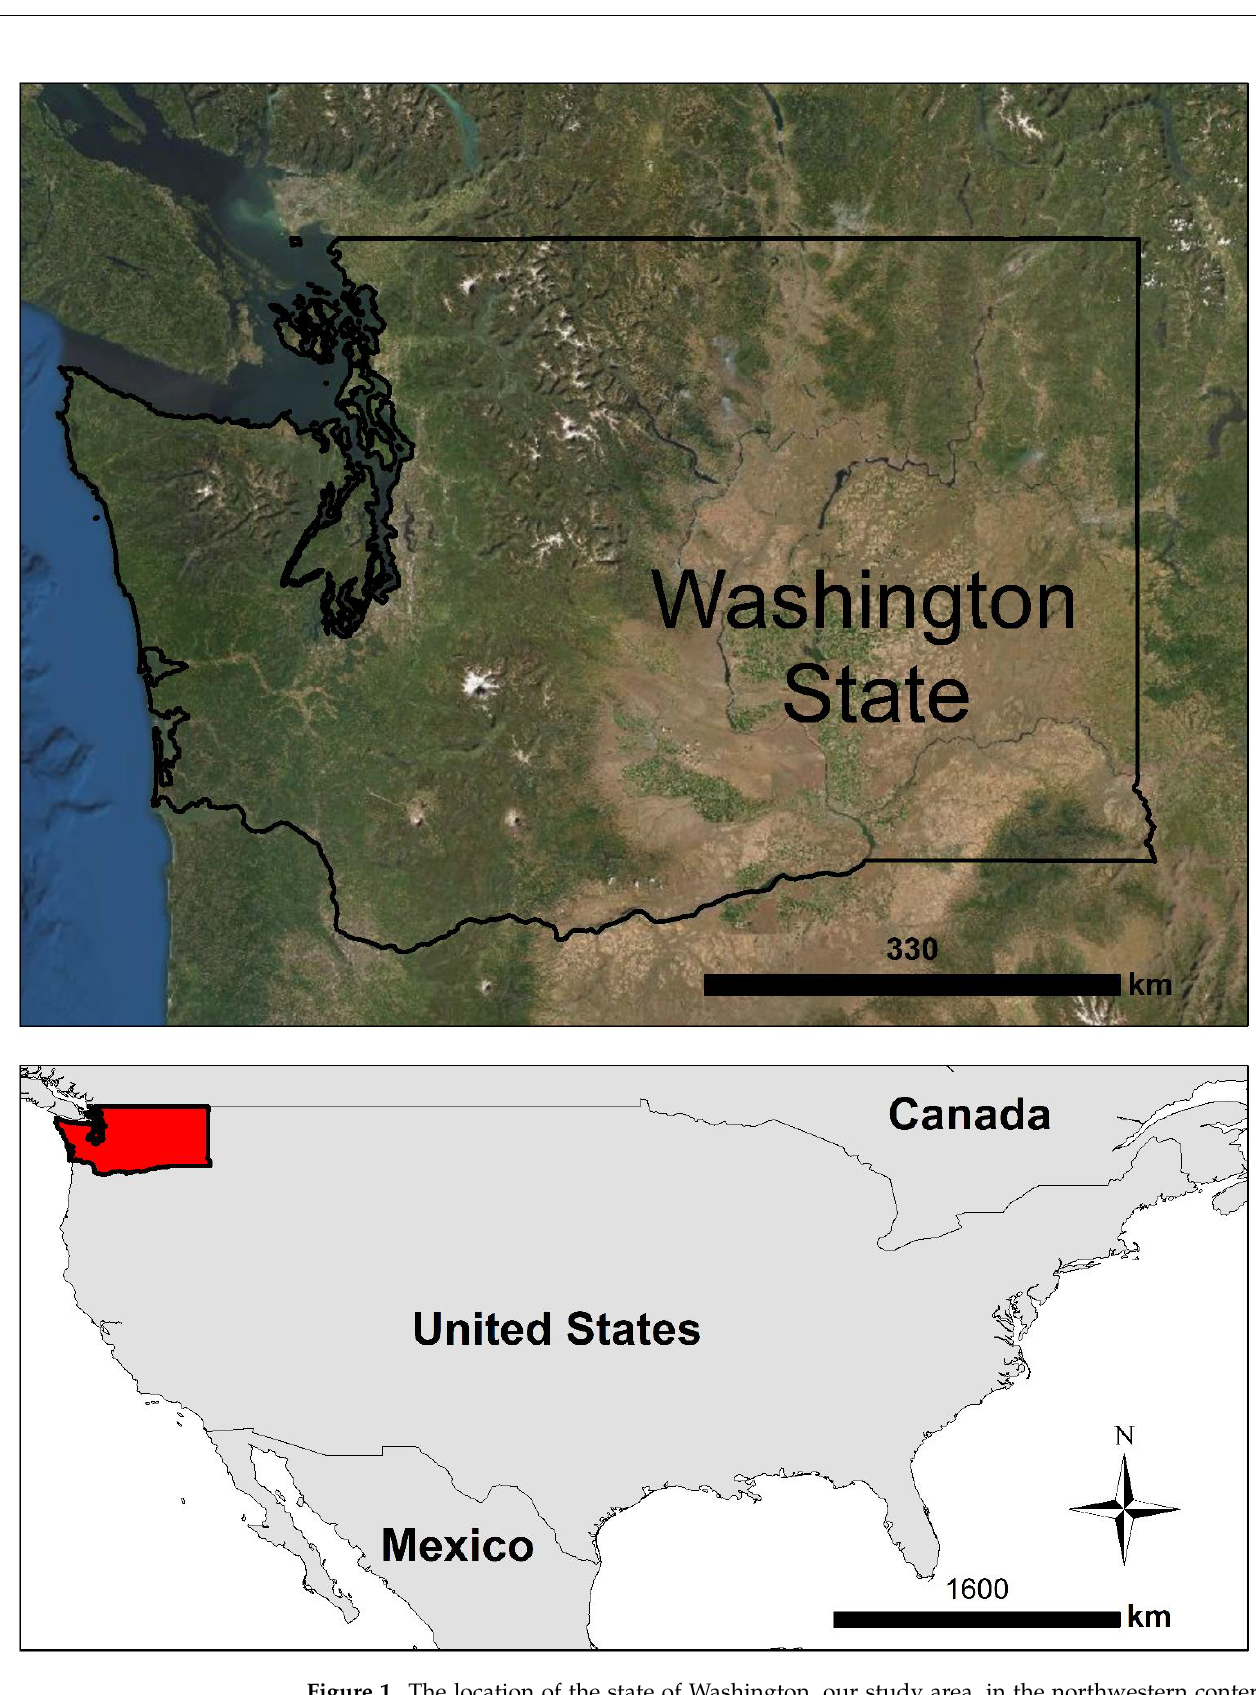
Figure 1. The location of the state of Washington, our study area, in the northwestern conterminous USA.